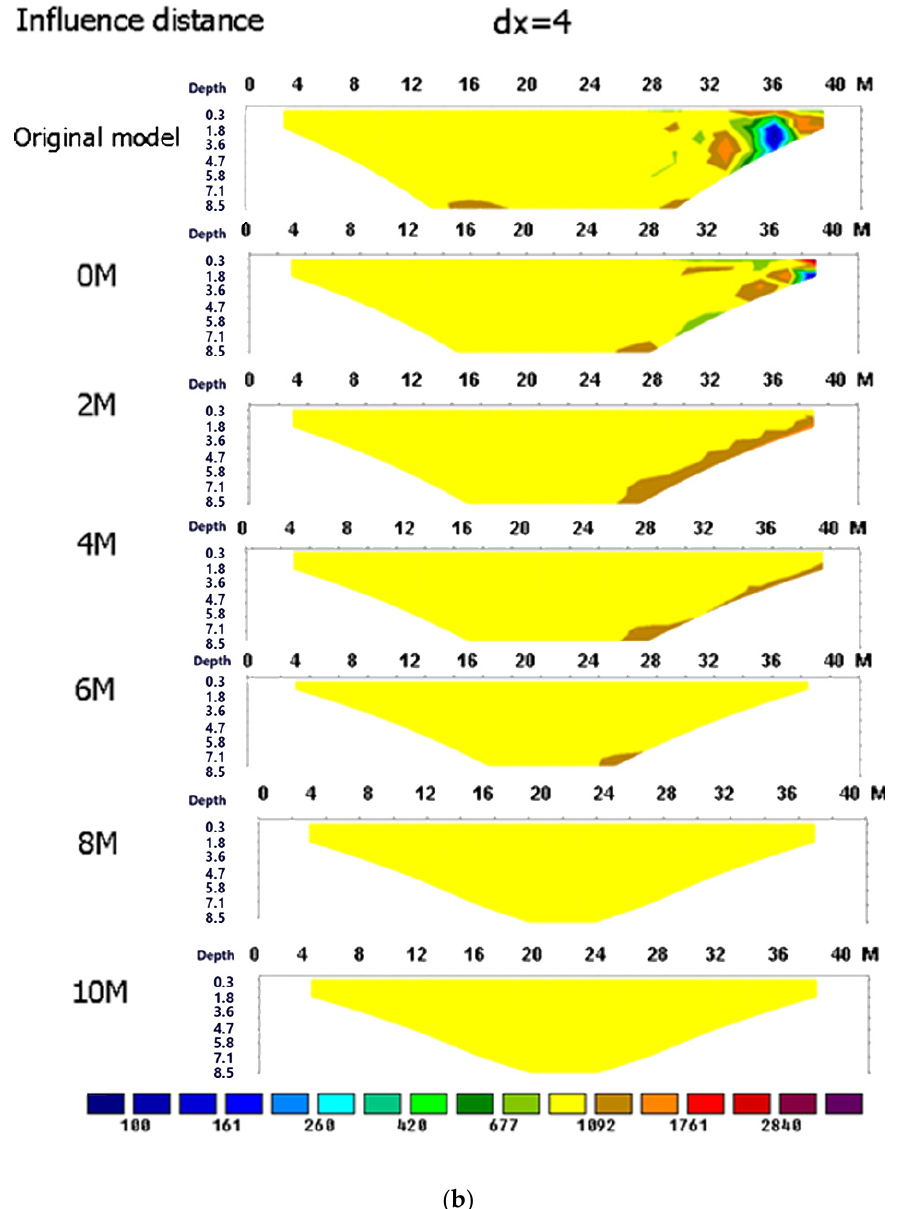
Figure 12. The influence situation of the boundary effect with different electrode spacing. ( a ) electrode spacing 2 m; ( b ) electrode spacing 4 m.